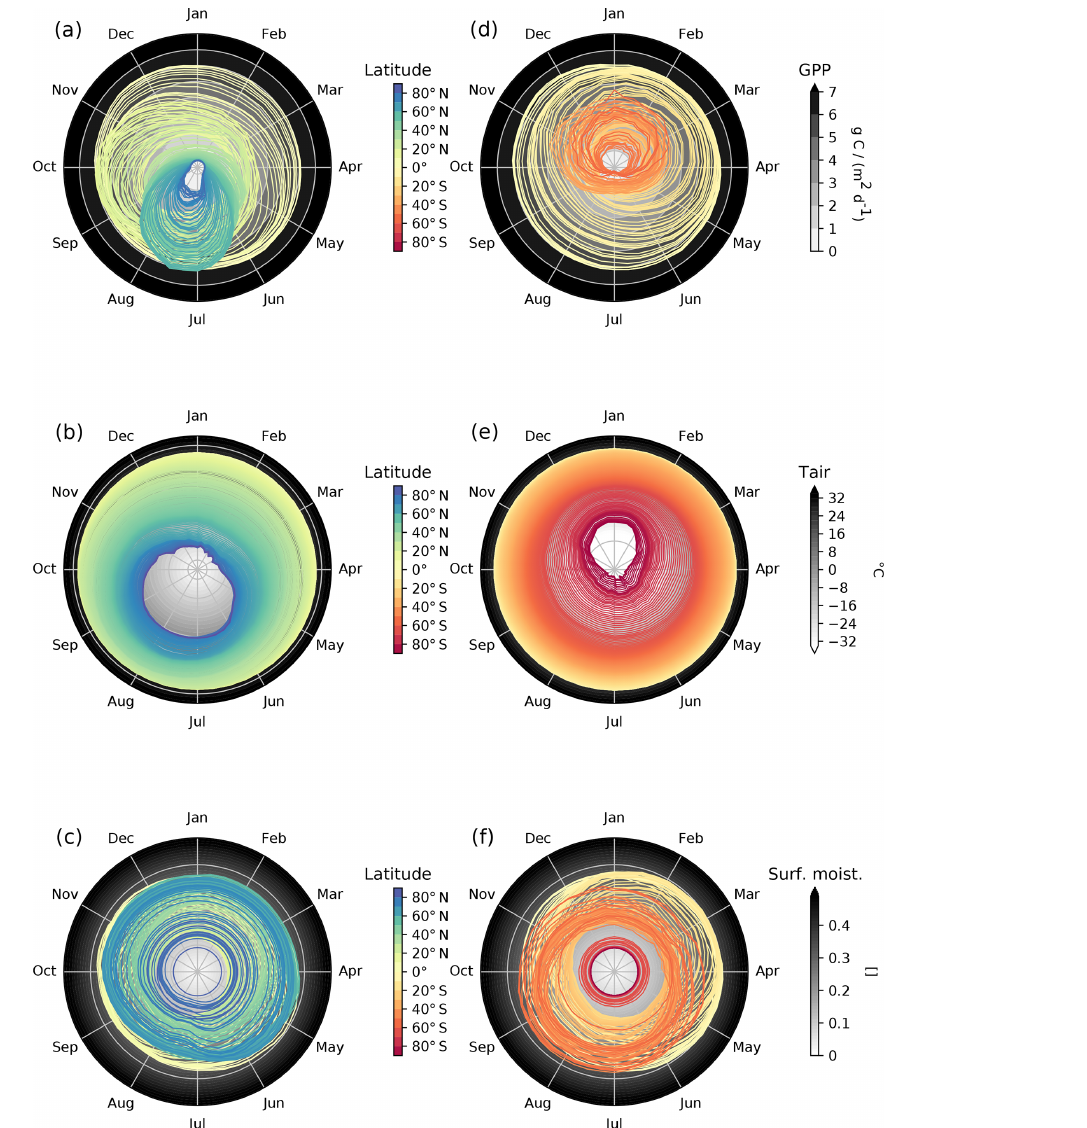
Figure 4. Polar diagrams of median seasonal patterns per latitude (land only). The values of the variables are displayed as grey gradients and scale with the distance to the centroid. For each latitude, we have a median seasonal cycle specified with the central colour code. Panels (a– c) show the patterns for the Northern Hemisphere; panels (d–f) are the analogous figures for the Southern Hemisphere. Here, we show the patterns for GPP, air temperature at 2m ( T air ), and surface moisture